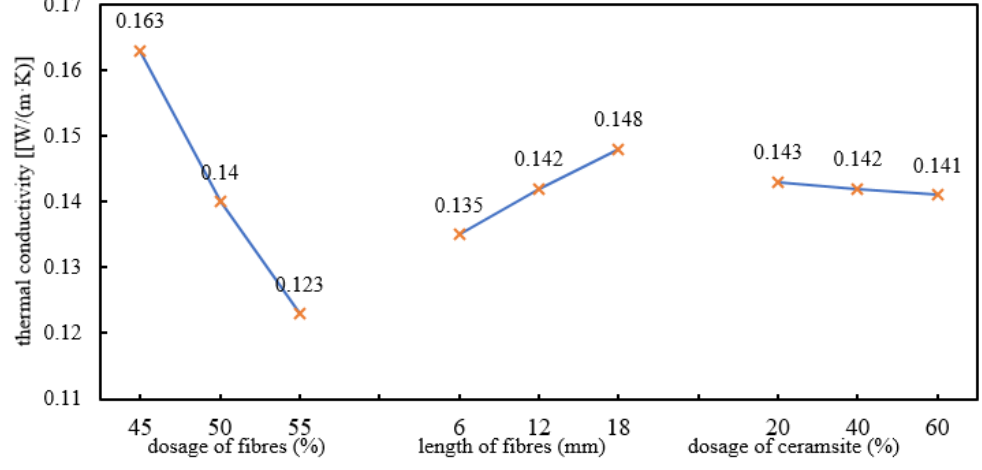
Figure 5. Trend in the thermal conductivity.